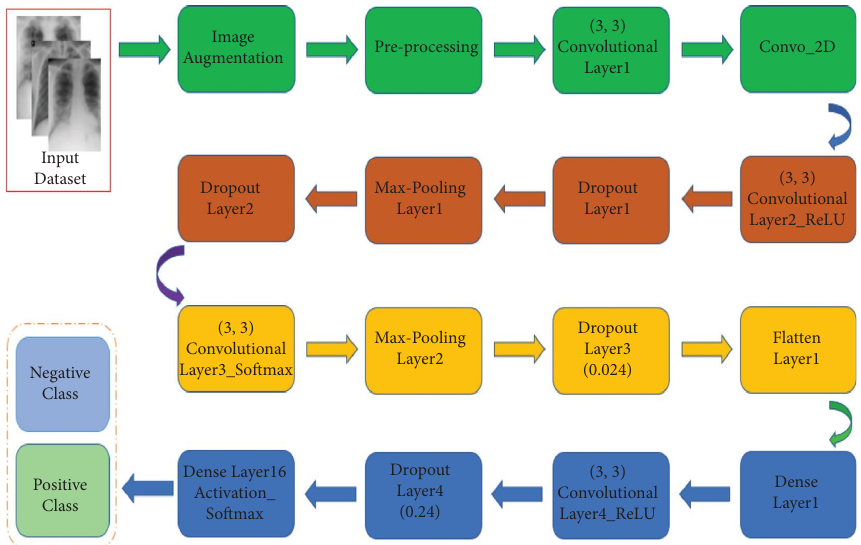
Figure 10: Block diagram of proposed ECNN